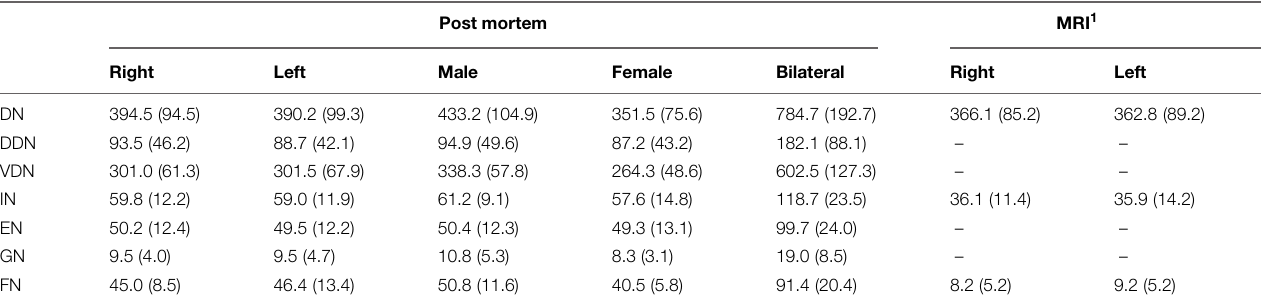
TABLE 2 | Mean volumes (mm 3 ) and SDs (in brackets) of each cerebellar nucleus of grouped hemispheres and sexes were calculated from the shrinkage corrected volumes of 10 post mortem brains. Male/female volumes represent the mean volumes of left and right hemisphere volumes. [(pair